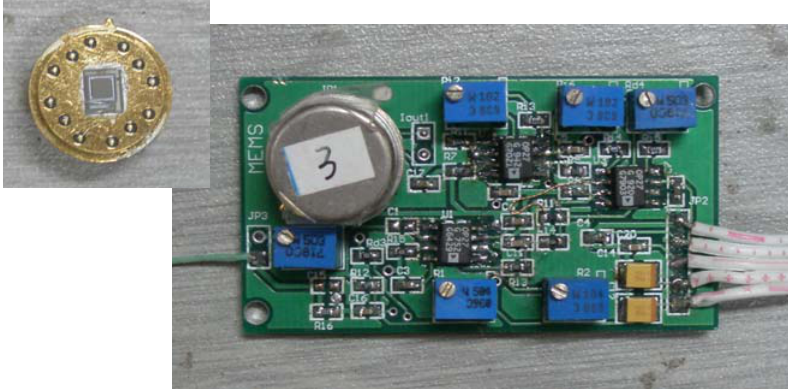
Figure 11. Photograph of accelerometer with signal processing circuit.